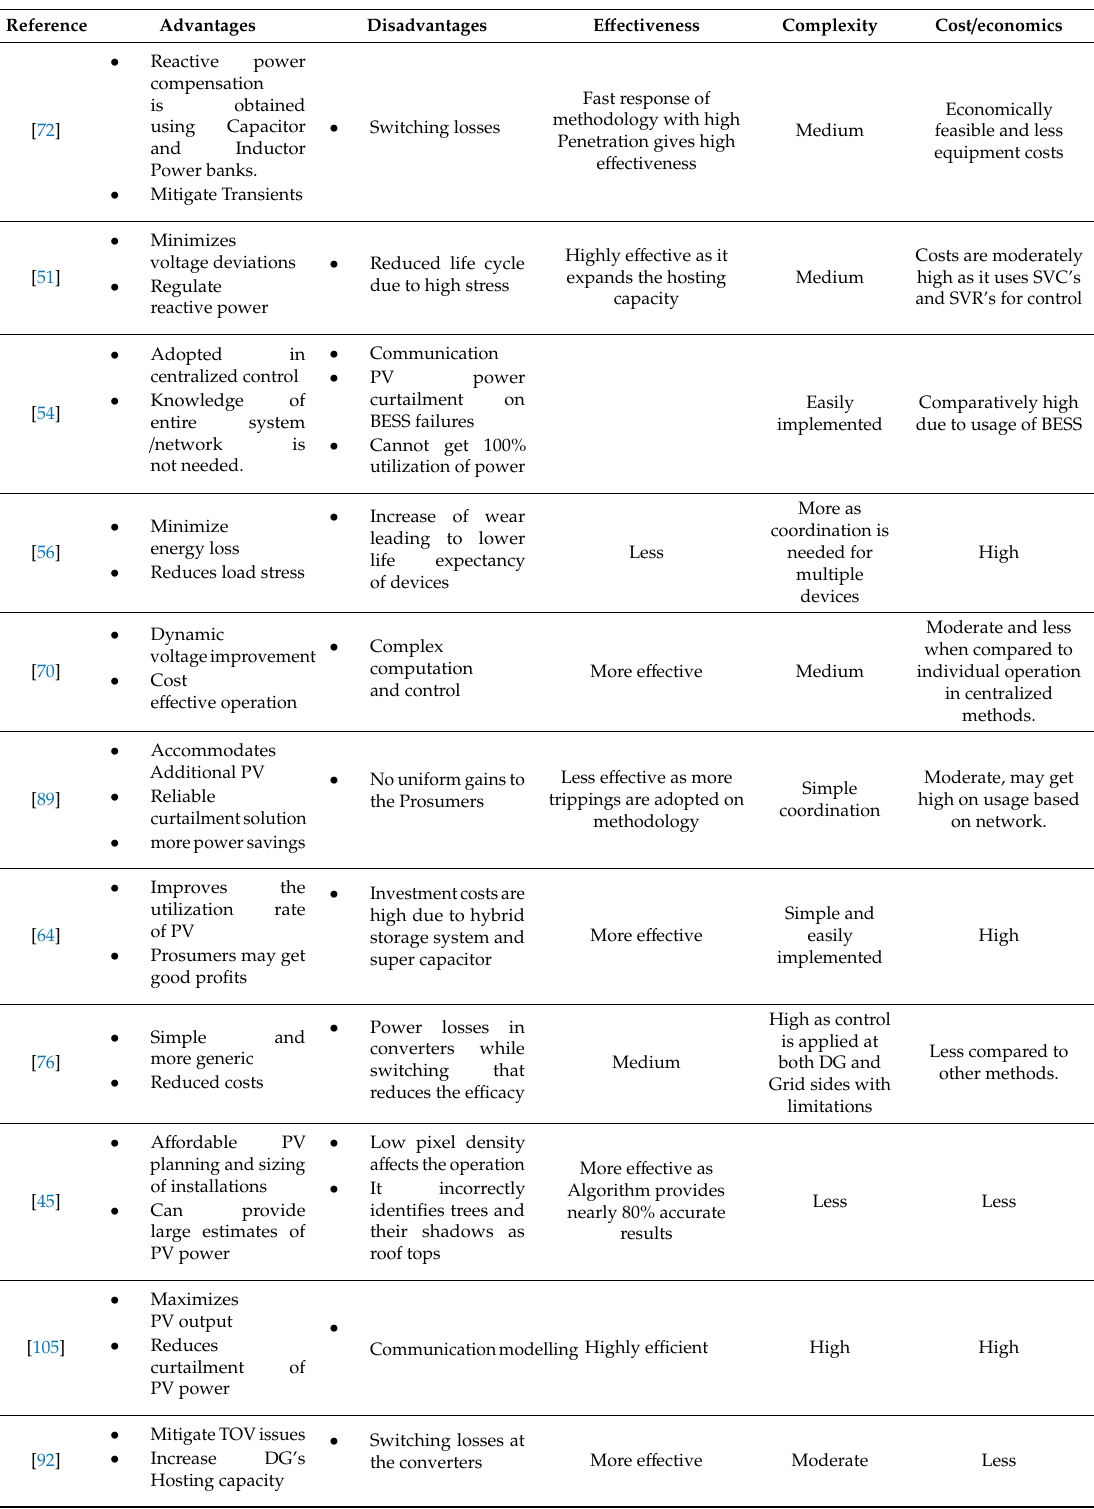
Table 2. Summary of the strategies involved for high penetration of PV power.